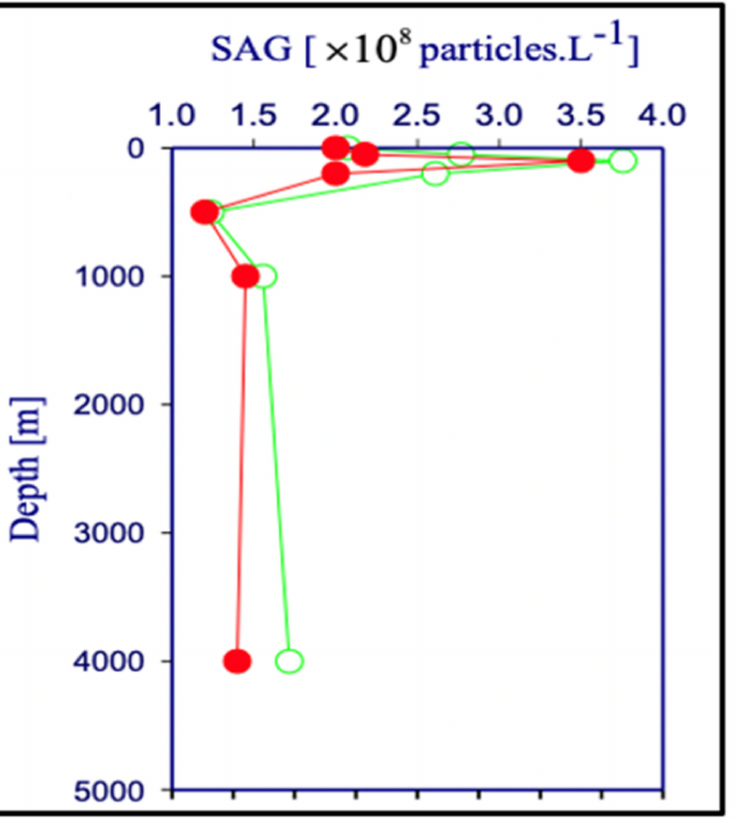
Figure 21. Typical results of MGs detection by flow cytometry—in closed red circles—and fluorescent quenching method—in open green circles. MG was fluorescently tagged with Chlortetracycline (CTC) that labels bound Calcium present in MG. Notice that the concentration of MG follows very closely the concentration of DOM MBP, which is the feedstock for self-assembly. Notice also that while CTC colorimetric method allows flow cytometry to count MG, and to image gels by fluorescence microscopy, it does not allow measurements of reduced organic carbon in